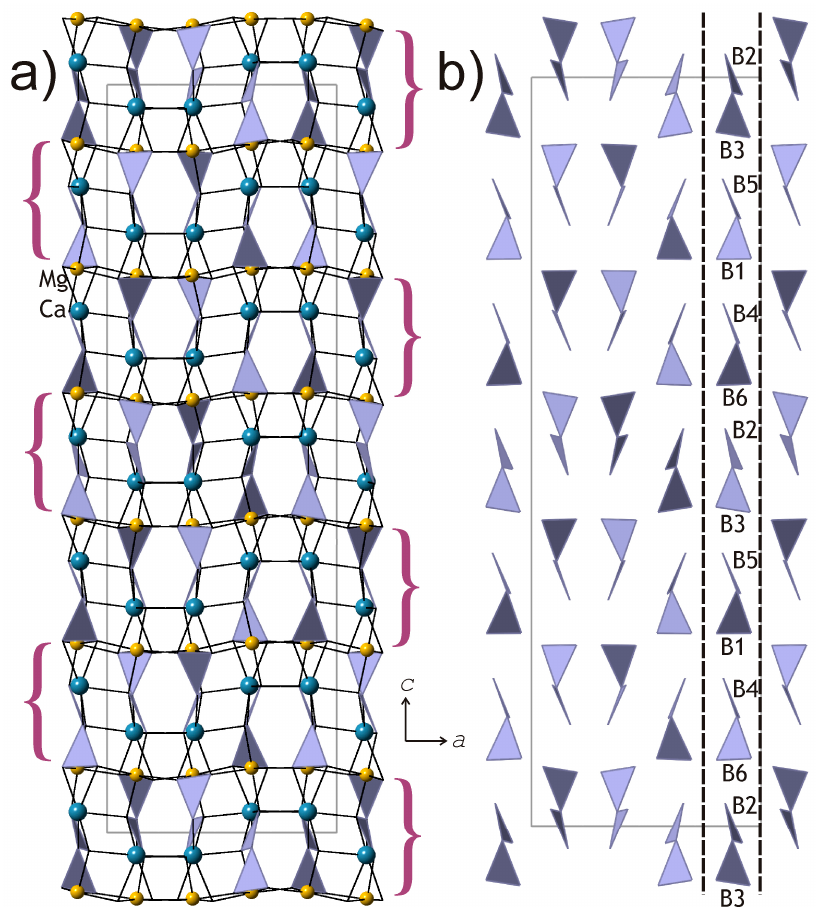
Figure 1. The crystal structure of kurchatovite projected along the b axis ( a ) and the arrangement of B 2 O 5 groups ( b ). The curved brackets in ( a ) denote the basic two-dimensional blocks, whereas the dashed lines in ( b ) indicate directions of division of the structure into single slices consisting of diborate groups.